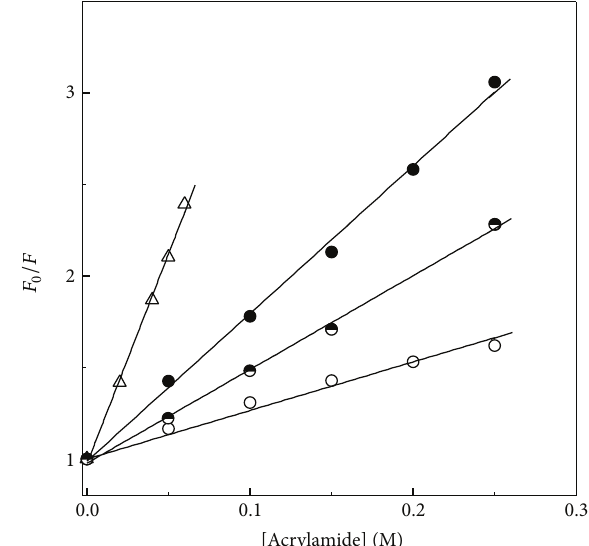
Figure 4: Stern-Volmer plots of different conformational states of BLA, as studied by acrylamide quenching using a protein concentration of 0.1 𝜇 M. Native state ( ⃝ ), acid-denatured state ( e ), and HFIP-induced state ( 8 ). Acrylamide quenching data obtained with NATA is shown by symbols ( △